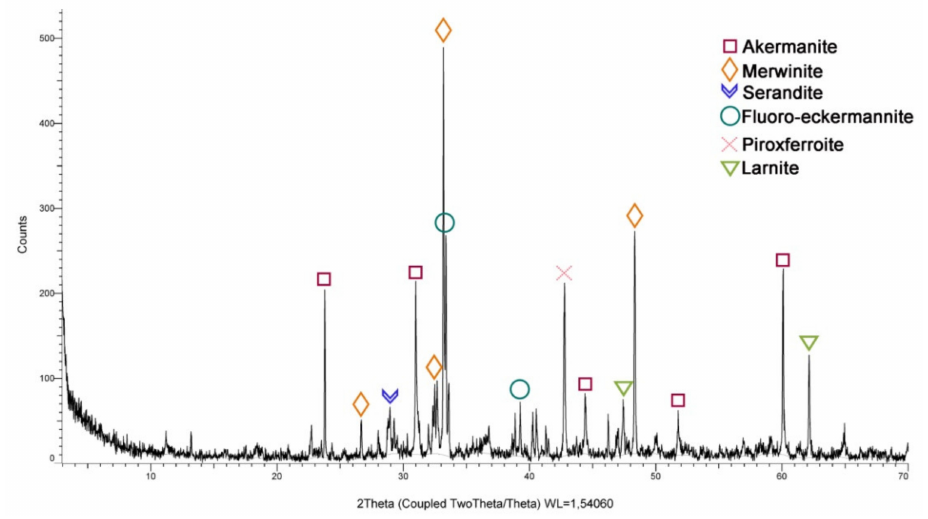
Figure 2. SSS diffractogram—XRD.